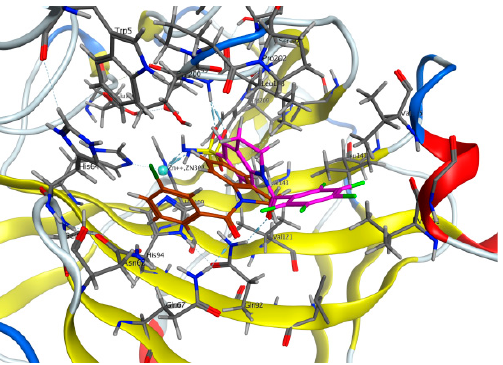
Figure 4. Docking of 3-chlorobenzoyl derivative 4f (brown) and 4e (purple) in the active site of CA IX (PDB 5sz5). IX (PDB